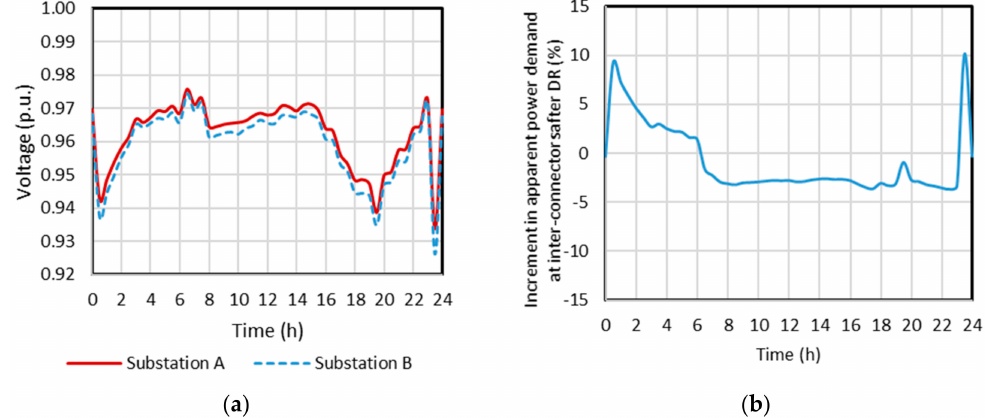
Figure 8. ( a ) Secondary voltage at transformers of both substations and ( b ) increment in apparent power flow through inter-connectors after the implementation of DR for scenario